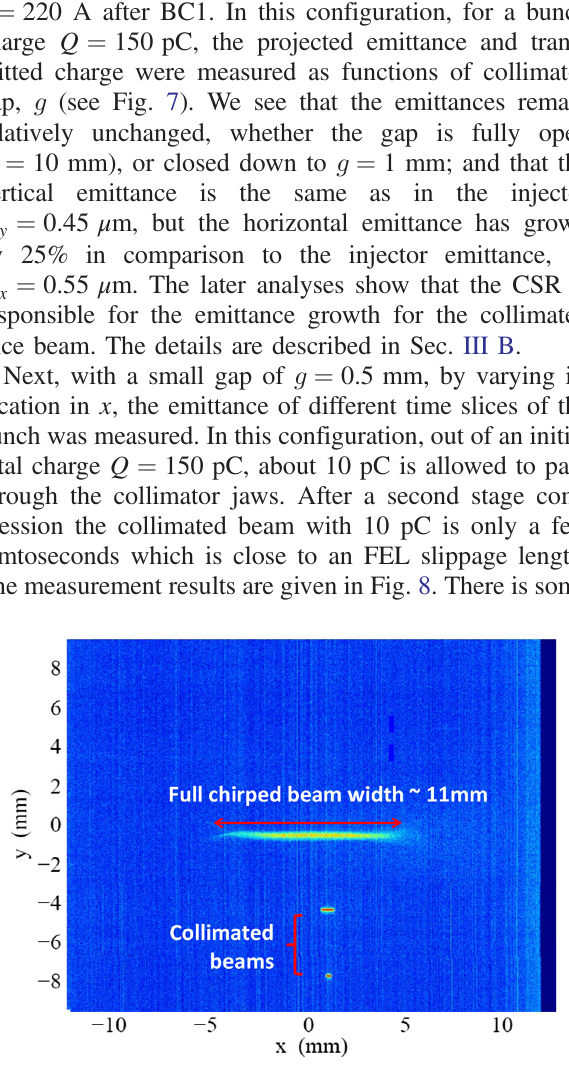
FIG. 6. Examples of measured beam images at the OTR screen just downstream of the collimator: the full, 150 pC chirped beam (top) and collimated beams with different collimator gaps (middle and bottom).